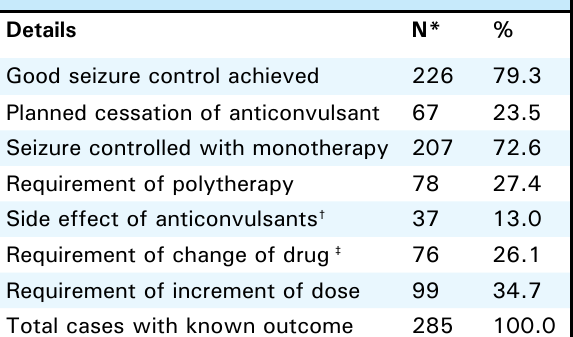
Table 4 . Details of treatment and